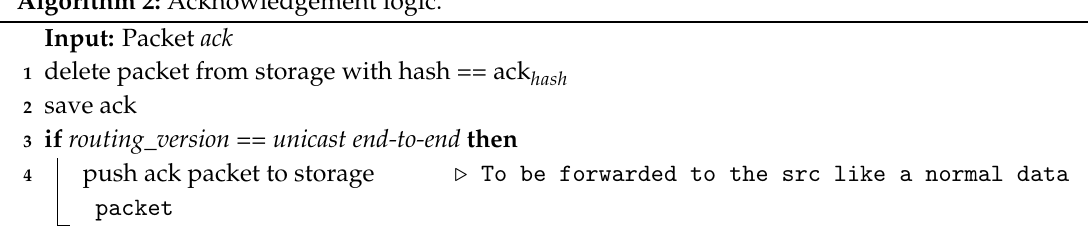
Algorithm 2: Acknowledgement